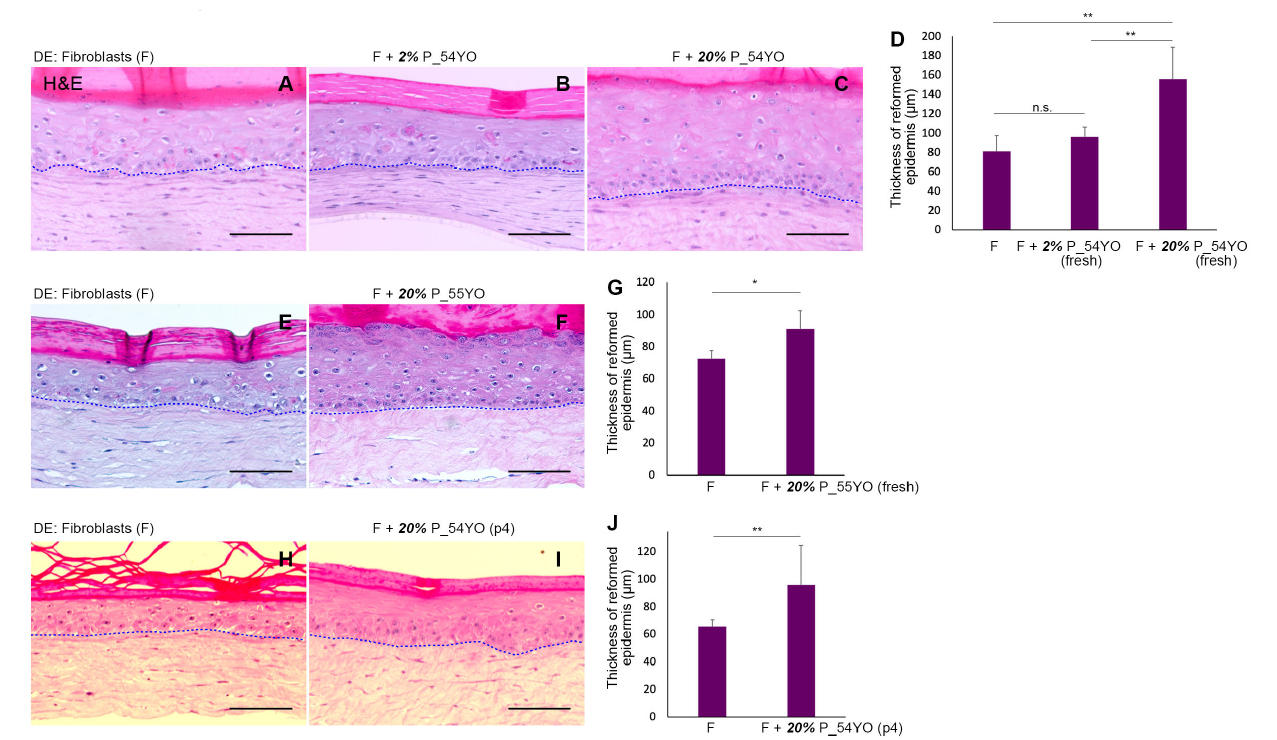
Figure 2. Epidermal regeneration ability of neonatal keratinocytes can be enhanced by increasing the incidence of aged pericytes in OCs. ( A – J ). Thickness of the epidermis reformed by neonatal keratinocytes was consistently greater when 20% dermal pericytes from aged donors (54 and 55) were included in the dermal equivalent ( D , E ) compared to neonatal fibroblasts alone (( A ) vs. ( C ); ( E ) vs. ( F ); ( H ) vs. ( I ); n = 3). 2% 54 yo dermal pericytes ( B ) did not increase epidermal thickness over fibroblasts ( B , D ). Cultured pericytes (p4) were used in H–I, whereas uncultured pericytes were used in ( A – G ). Quantitation of epidermal thickness ( D , G , J ) was obtained from 6–8 random fields/OC. Error bars represent mean ± SD. * = p < 0.05, ** = p < 0.01, n.s. = not significant. Scale Bar: 100 µ